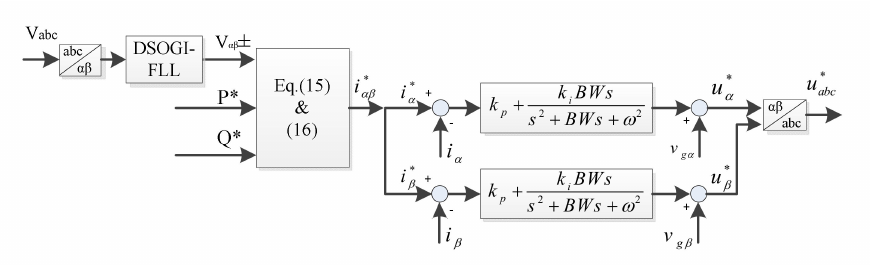
Figure 10. The inverter current control loop by implementing the PNSC